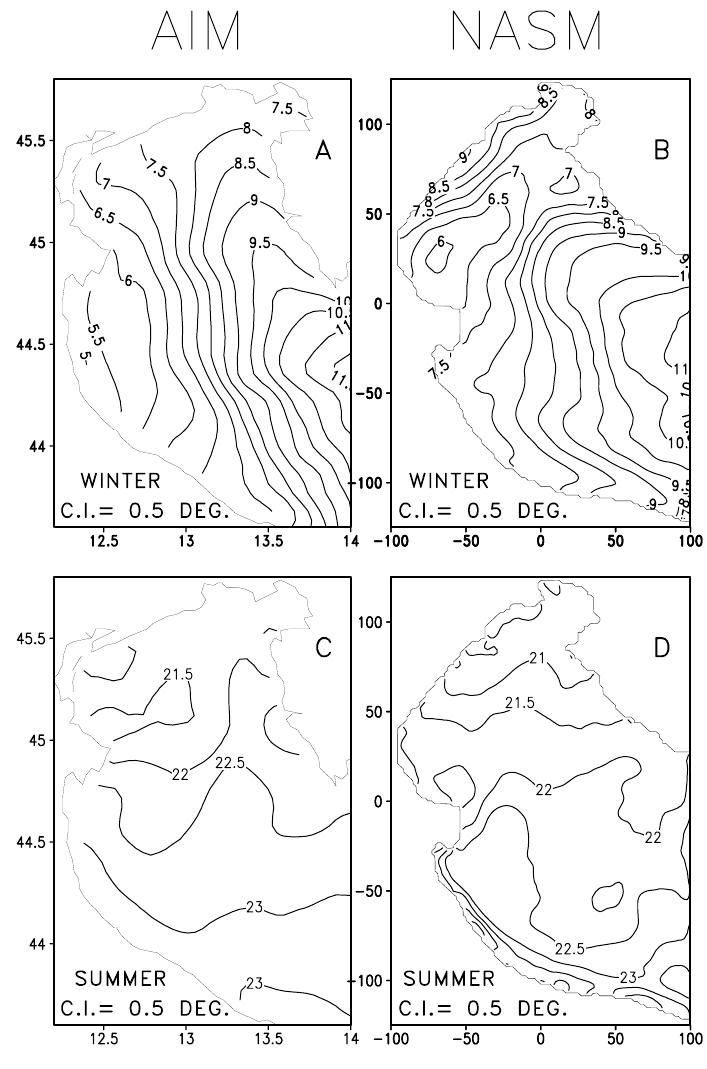
Fig. 17. Northern Adriatic Shelf